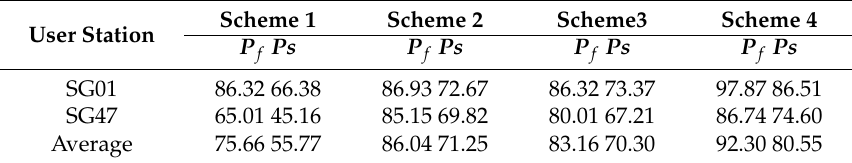
Table 4. 10-min fix rate ( P f ) and successful rate ( P s ) with different